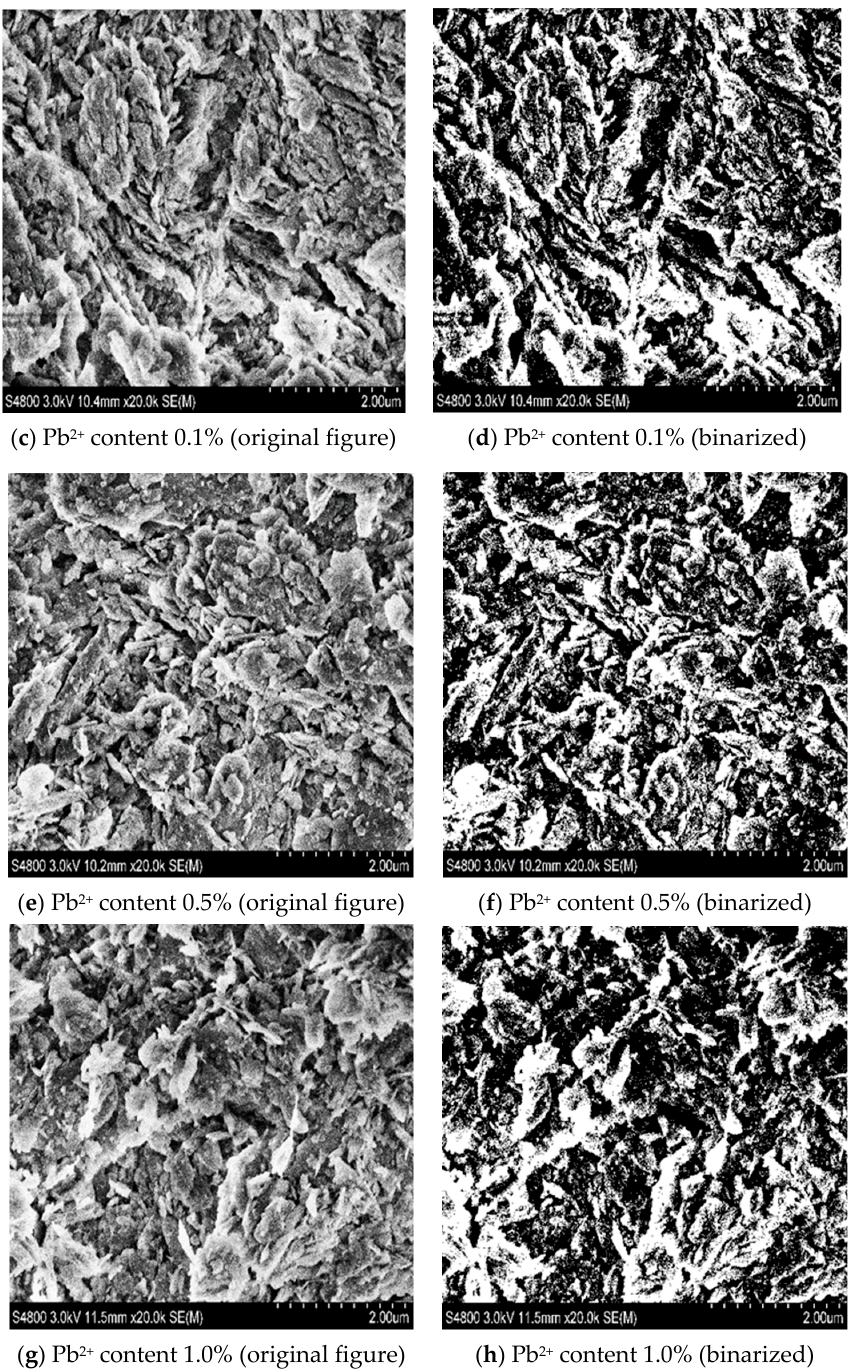
Figure 4. Microstructure of soil after 5 days of contamination with different concentrations of lead ions (20,000×).